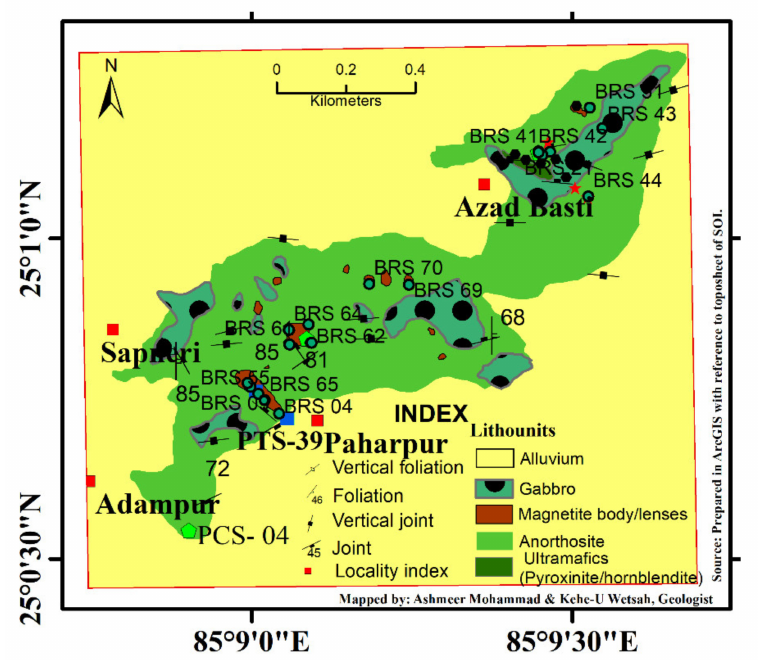
Figure 4. Geological map of Paharpur area, in parts of Gaya and Jehanabad districts,